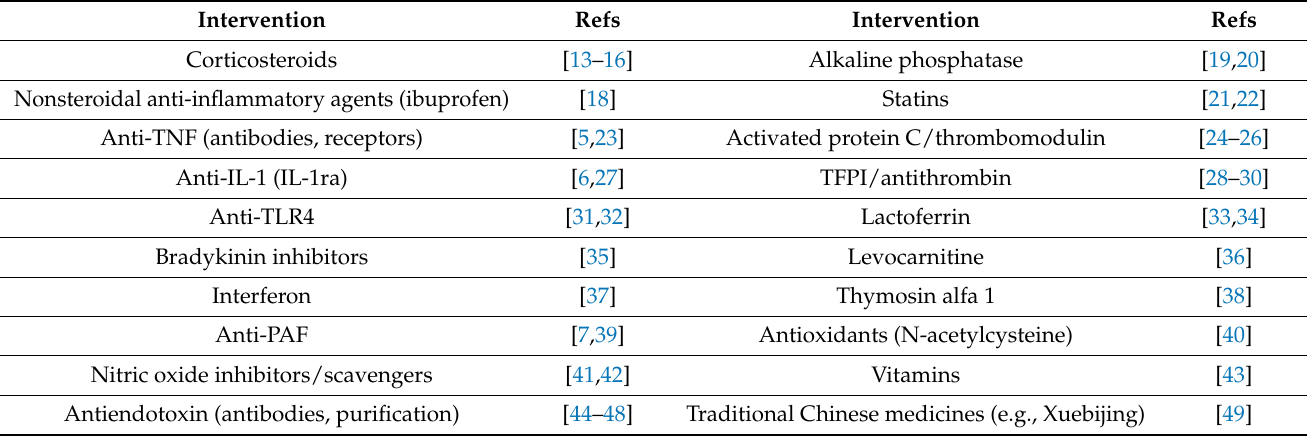
Table 1. Some interventions targeting the hyperinflammation of sepsis that have been assessed in clinical trials, with some key